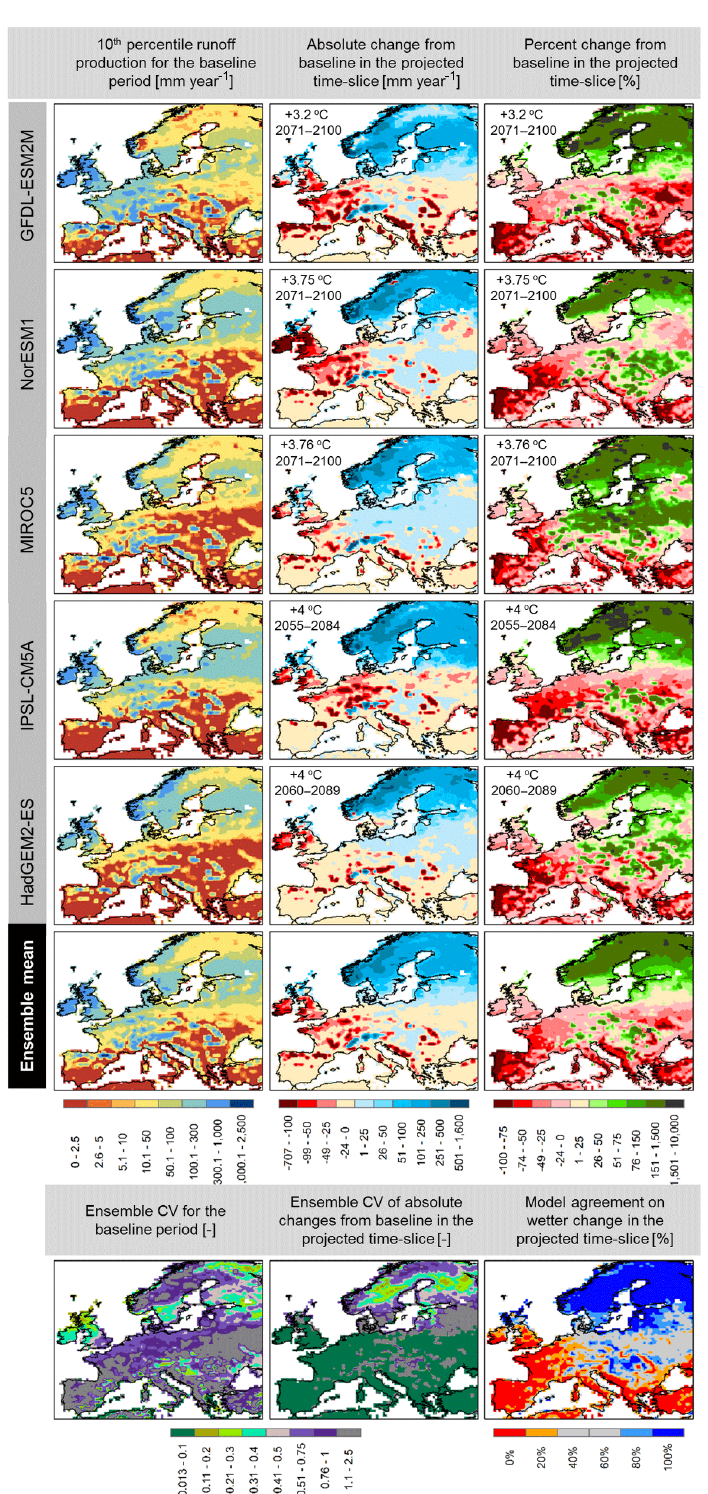
Figure 3. 10th percentile of runoff production from raw Euro-CORDEX data for all dynamical downscaled GCMs and their ensemble mean. 10th percentile runoff production derived on an annual basis and averaged over the baseline period (1976–2005), absolute change in 10th percentile runoff in the + 4 SWL projected time slice (middle column panels) and percent change in the + 4 SWL projected time slice (right column panels). Bottom row panels: coefficient of variation of the ensemble members for the baseline period (left column panels), coefficient of variation of the projected absolute changes in the + 4 SWL projected time slice (middle column panels) and model agreement towards a wetter change in the + 4 SWL projected time